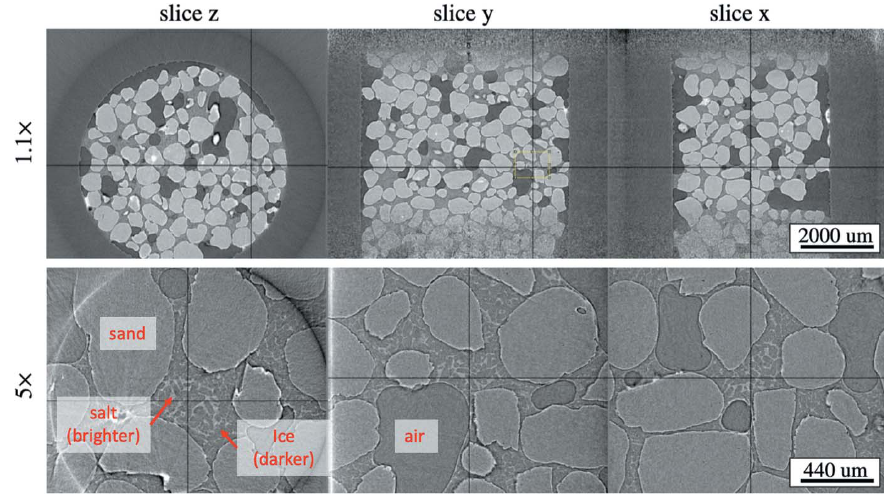
Figure 5 Real-time 3D zooming to the region of interest showing ice crystals formation surrounded by brighter brine. Rotation speed and exposure time are the same for both